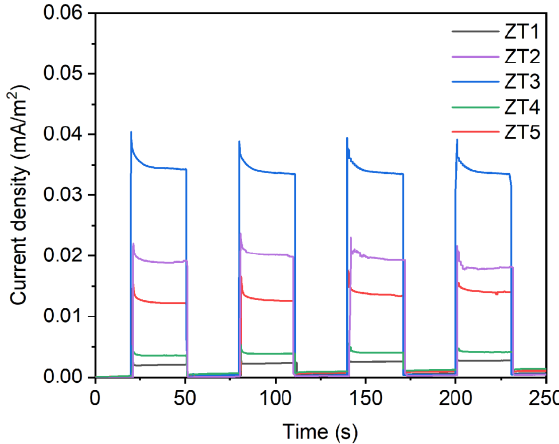
Figure 8. Transient photocurrent responses of the as-prepared simples. The photocatalytic ability of the TiO 2 /ZnO nano-films was monitored for the degra- dation Of RhB under UV-light illumination (Figure 9a). Bare ZnO nano-film and TiO 2 nano-film were used as control samples. The preparation process was the same as ZT3 but in absence of the TiO 2 layer and the ZnO layer, respectively. It was found that the ZT3 exhibited remarkably superior photocatalytic activity, by removing 88.0% RhB in 90 min duration and 90.8% RhB in 120 min duration. Hence, the ZnO coupled with the TiO 2 through magnetron sputtering by using a metallic Ti target at an O 2 /Ar ratio of 10:35 could dramatically enhance the photocatalytic performance of TiO 2 heterojunction under UV light illumination. Hole scavenger (tartaric acid, TA), electron scavenger (potassium per- sulphate, KPS), and superoxide anion radical scavenger (p-Benzoquinone, BQ) were added to ascertain the photocatalytic mechanism. As shown in Figure 9b, hole and superoxide anion radical play the dominant role. The reusability of the nano-films was tested, ZT3 removed 88.4% RhB in 120 min after the fourth ring (Figure 9c). The surface of nano-films did not change significantly after the photocatalytic test (Figure 9d). rate constant (k app ) could be described with the Equation (4):